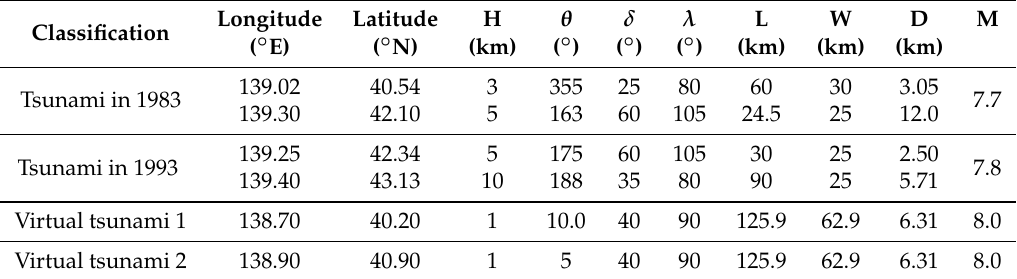
Table 1. Fault parameters of historical tsunamis and virtual tsunamis.